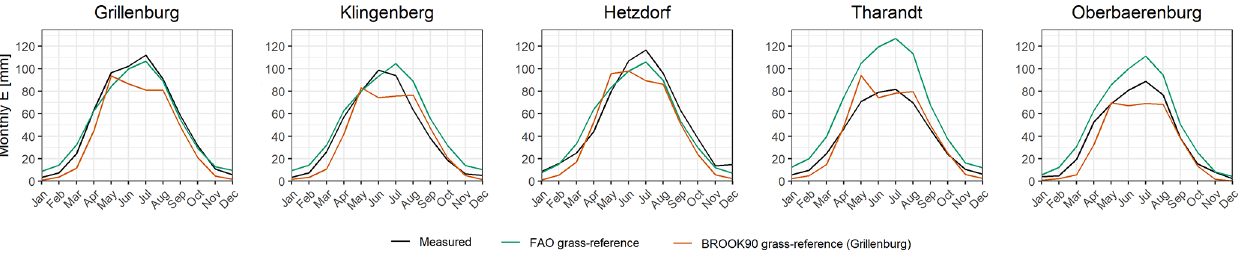
Figure 10. Observed and modelled monthly mean net energy on canopy and ground